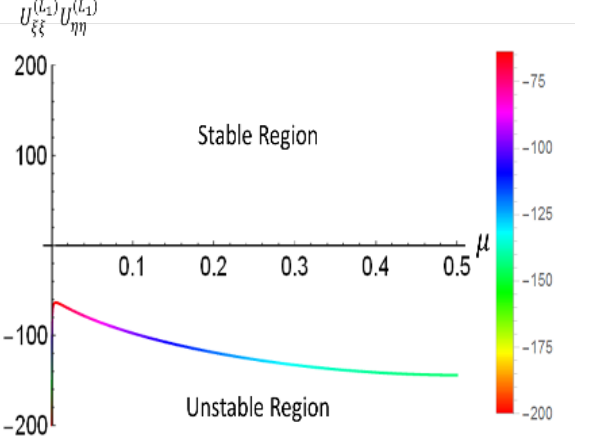
Figure 5. The growth of a small displacement for a test particle placed at L 2 vs. f .